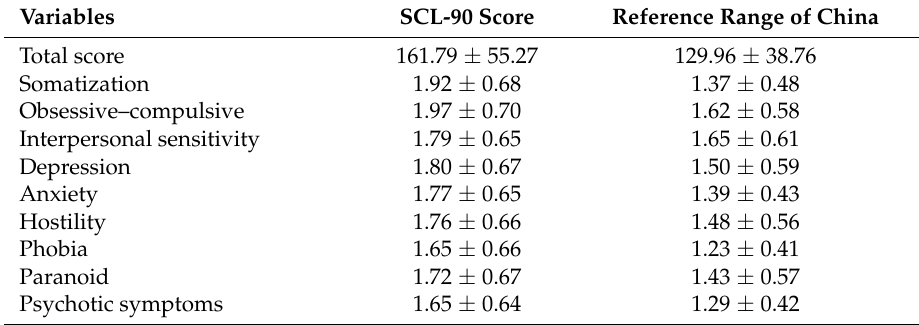
Table 2. Assessment results of each component and the total score of Symptom Checklist 90 (SCL-90) ( χ ± s )